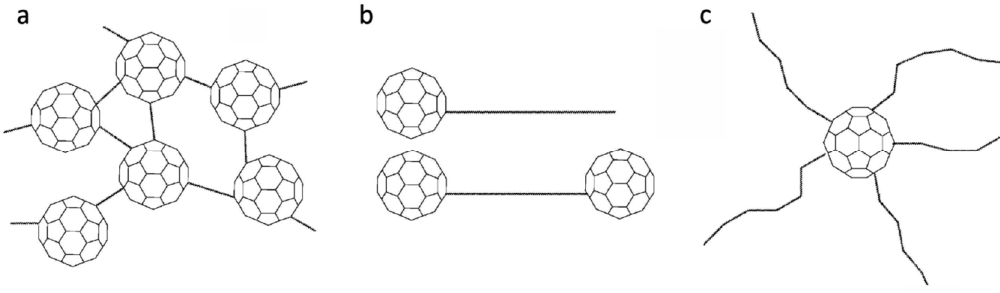
Figure 5. Schematic illustrations of ( a ) crosslinked C 60 polymer, ( b ) end-capped polymers, ( c ) star- shaped polymer